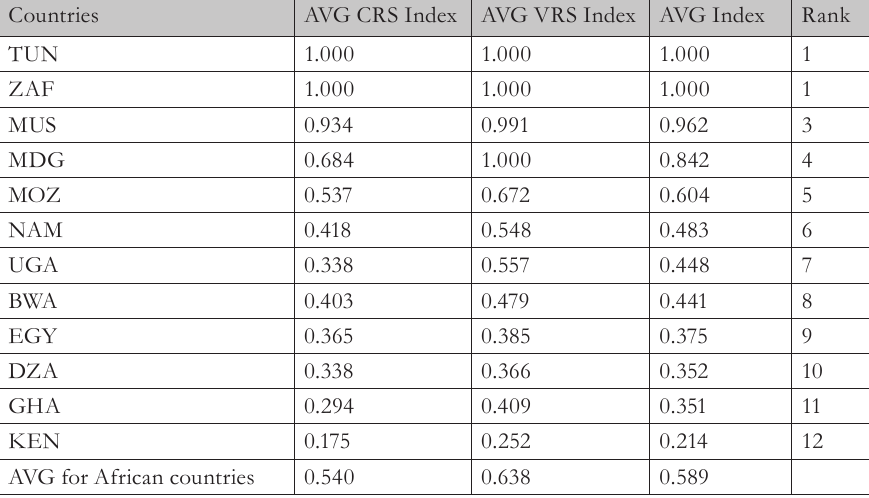
Tab. 5 – Efficiency Ranking for African countries. Source: own research